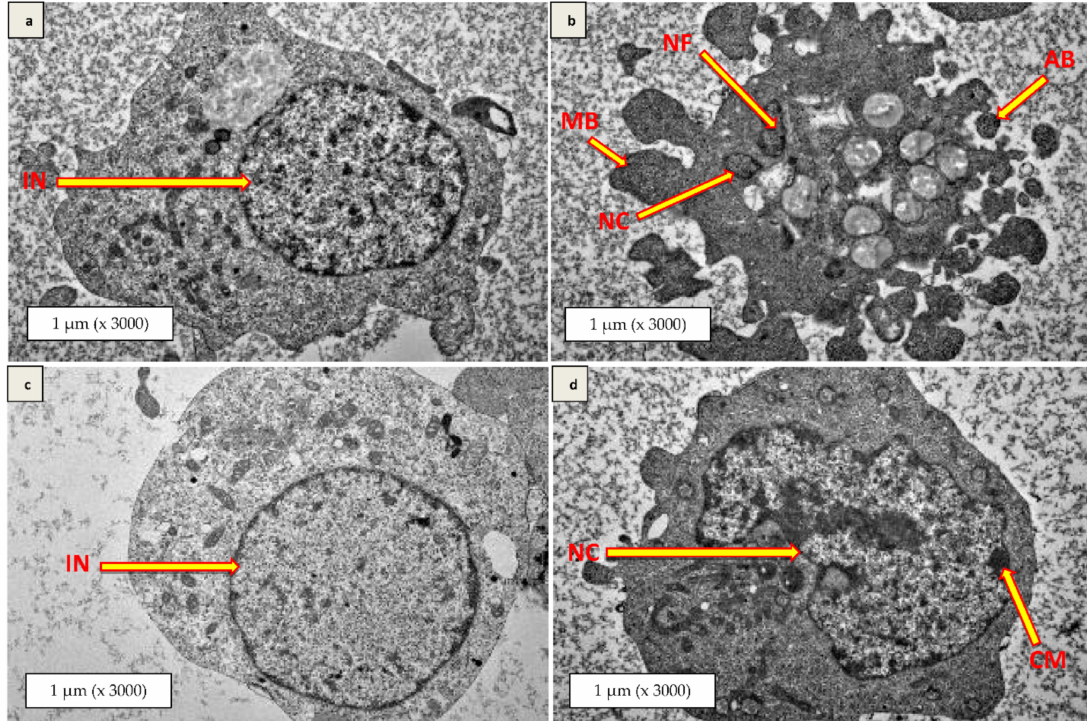
Figure 7. Internal morphological analysis of differentiated SH-SY5Y cells by transmission electron microscopy. ( a ) Untreated differentiated SH-SY5Y cells, ( b ) 24 h H 2 O 2 -exposed cells, ( c ) 48 h Kefir B pre-treated plus 24 h H 2 O 2 -exposed cells, and ( d ) 48 h Kefir C pre-treated plus 24 h H 2 O 2 -exposed cells. IN = intact nucleus, NC = nuclei convolution, CM = chromatin margination, MB = membrane blebbing, AB = apoptotic bodies, NC = nuclear condensation, NF = nuclear fragmentation. Magnification (x